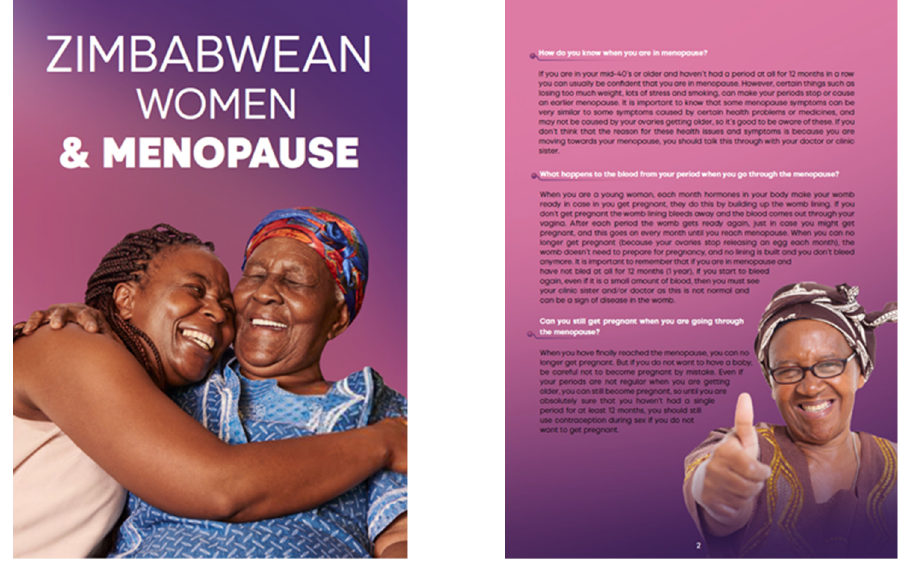
Figure 2. Prototype designs in Zimbabwe presented at workshops before evaluation and refine-